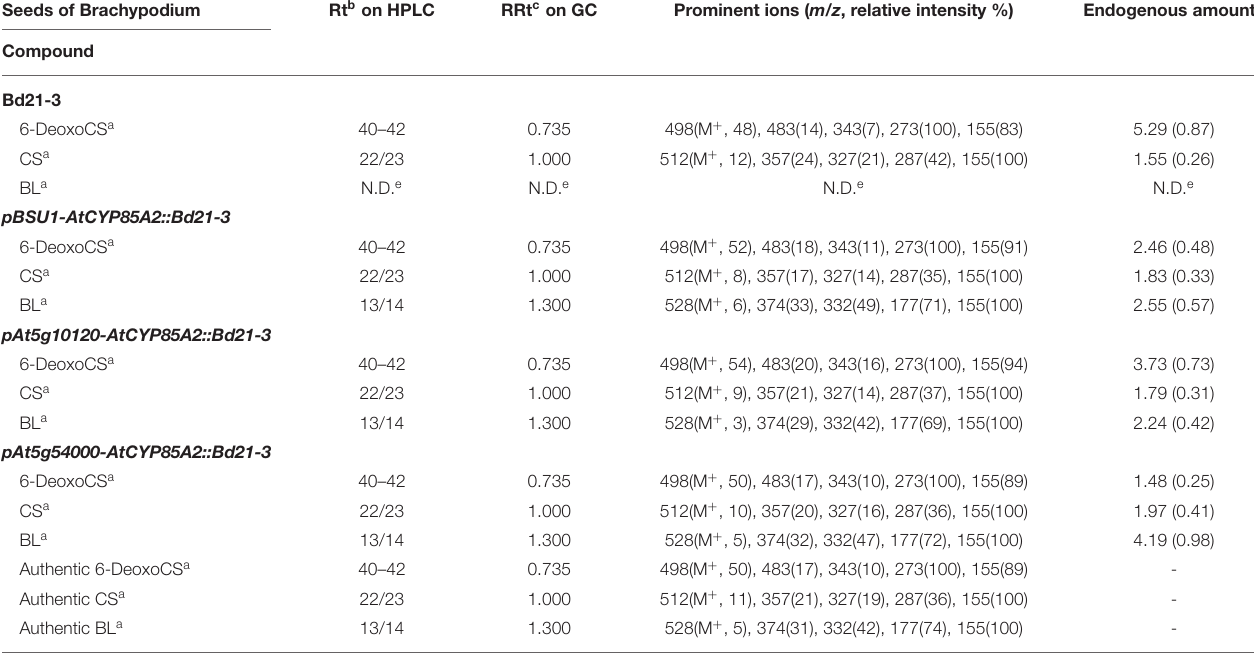
TABLE 1 | Quantification of endogenous BRs (6-deoxoCS, CS, and BL) in seeds of Brachypodium. Seeds of Brachypodium Rt b on HPLC RRt c on GC Prominent ions ( m/z , relative intensity %) Endogenous amount